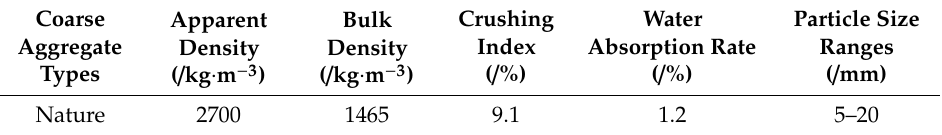
Table 2. Basic physical properties of coarse aggregate.